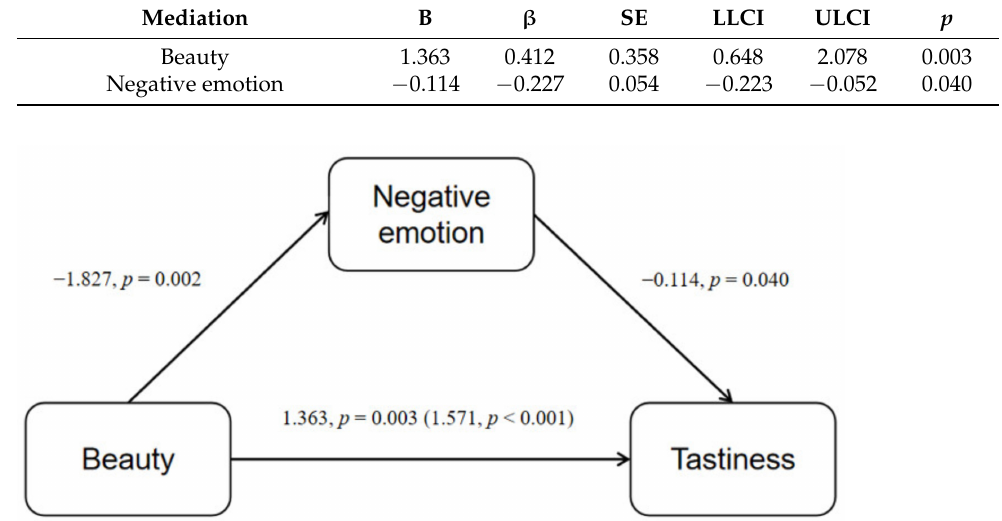
Figure 9. Mediation of the relationship between beauty and tastiness by negative emotion. Analysis was limited to participants in the expressive aesthetic group.